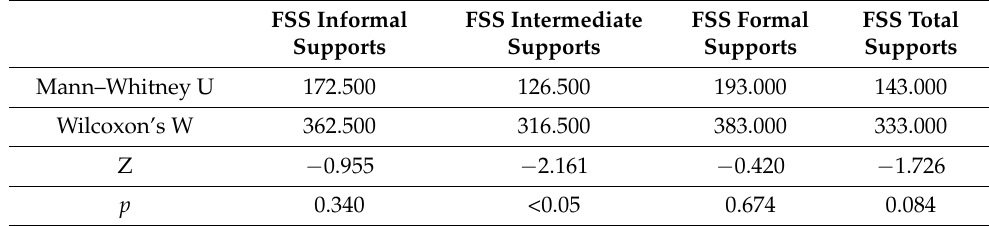
Table 8. Support network: informal supports, intermediate supports, and formal